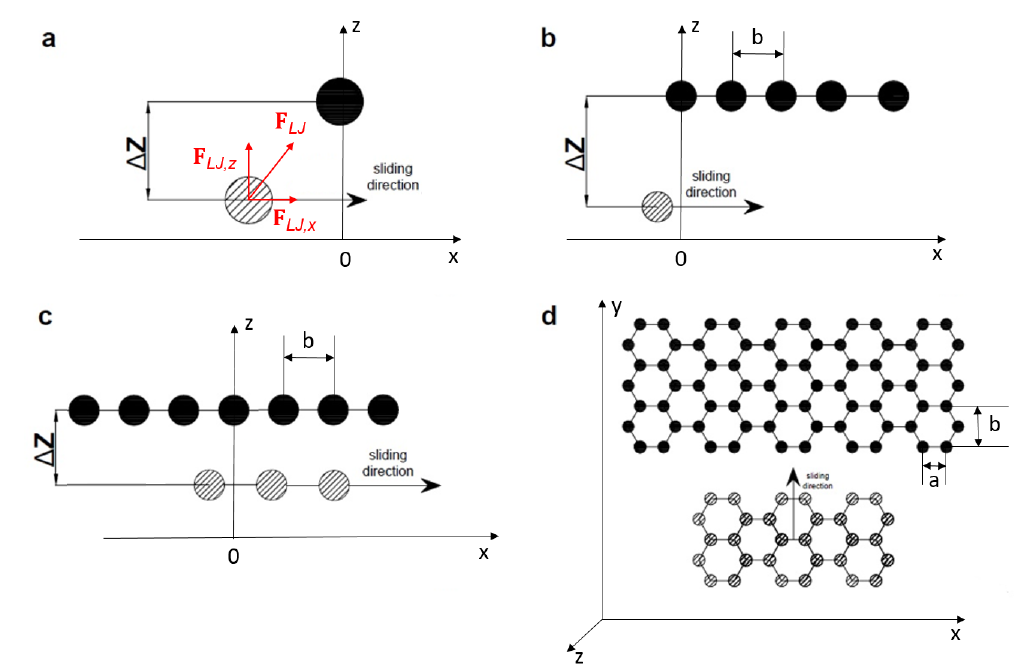
Figure 1. Sliding configurations: black dots represent fixed carbon atoms, while dashed dots represent sliding ones. ( a ) A pair of sliding atoms; ( b ) An atom slides over a chain of atoms; ( c ) A pair of sliding chains of atoms; ( d ) A pair of graphene sheets at ∆ Z distance sliding along the y direction. The resulting LJ forces and potentials between the carbon-based nanostructures have been computed to assess the effect of interlayer spacing and structure size on the sliding dynamics of each configuration.